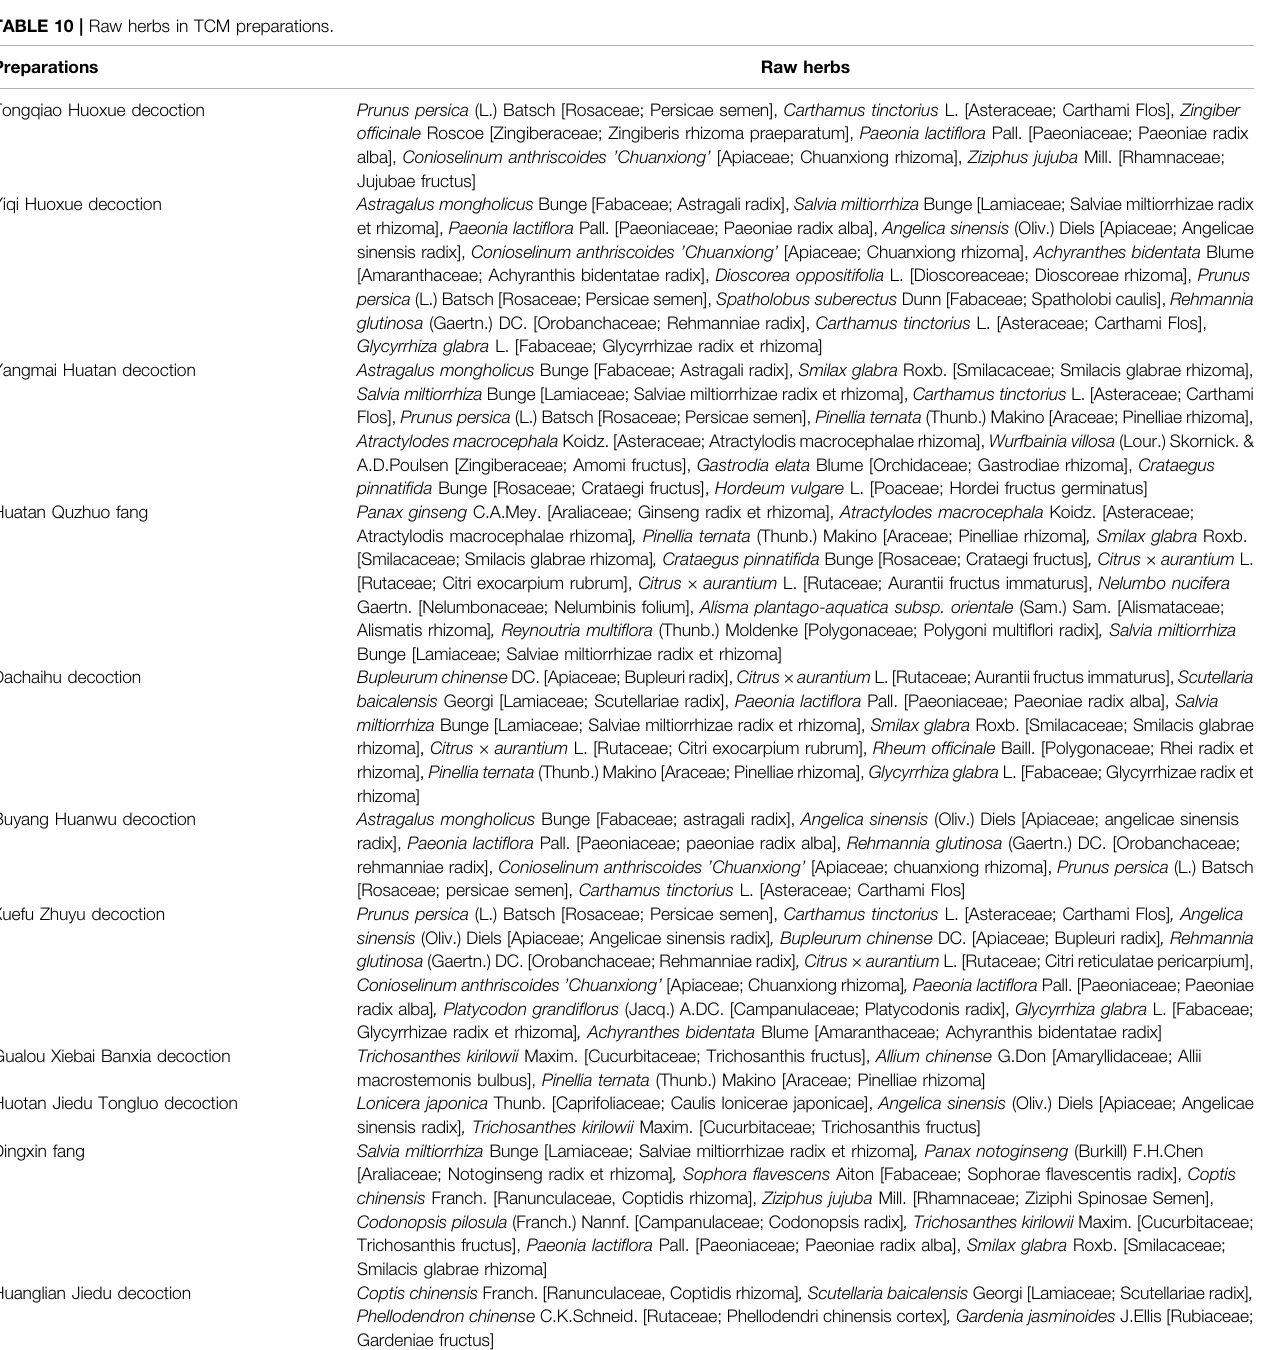
TABLE 10 | Raw herbs in TCM preparations. Preparations Raw